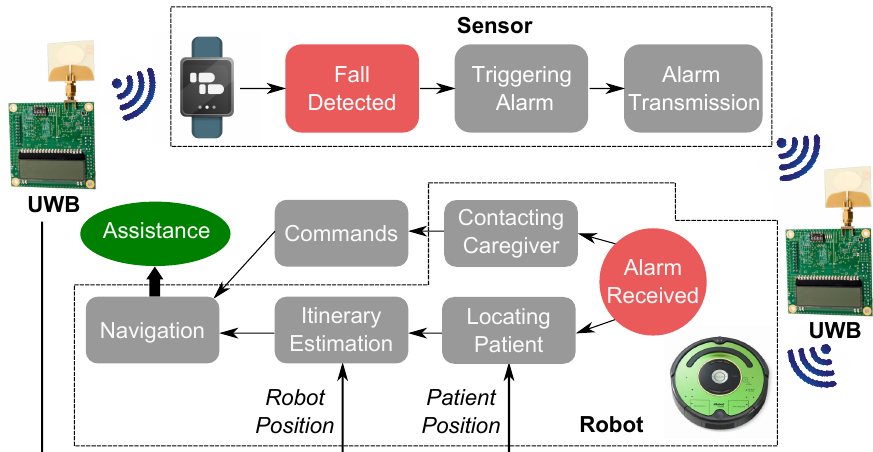
Figure 1. Schematic representation of the proposed fall detection system. When a fall, is detected an alarm notification is transmitted using the Decawave UWB-based system from the wearable sensor to the robot. The robot can open a communication channel with the emergency response center where personnel can manually control the robot and navigate the home environment to check the conditions of the older adult. Alternatively, the robot can autonomously navigate the environment using the UWB anchors as reference, check the conditions of the older adult, and assess if an alarm notification should be relayed to the emergency response